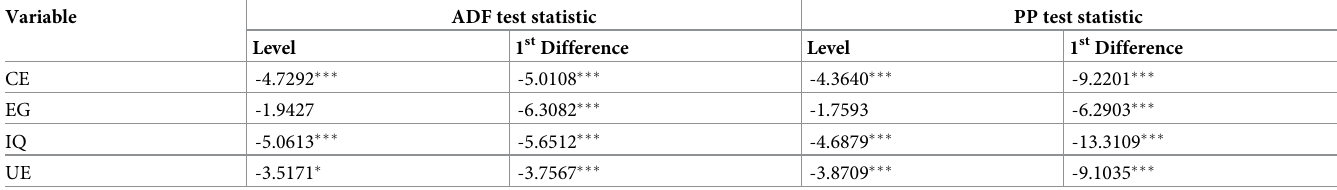
Table 2. Series stationarity